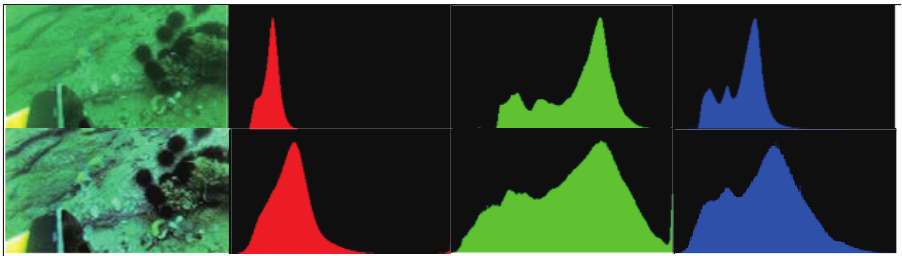
Figure 6. Comparison between original ( top ) and enhanced ( bottom ). It can be seen that the grayscale histogram of the processed image has a larger grayscale